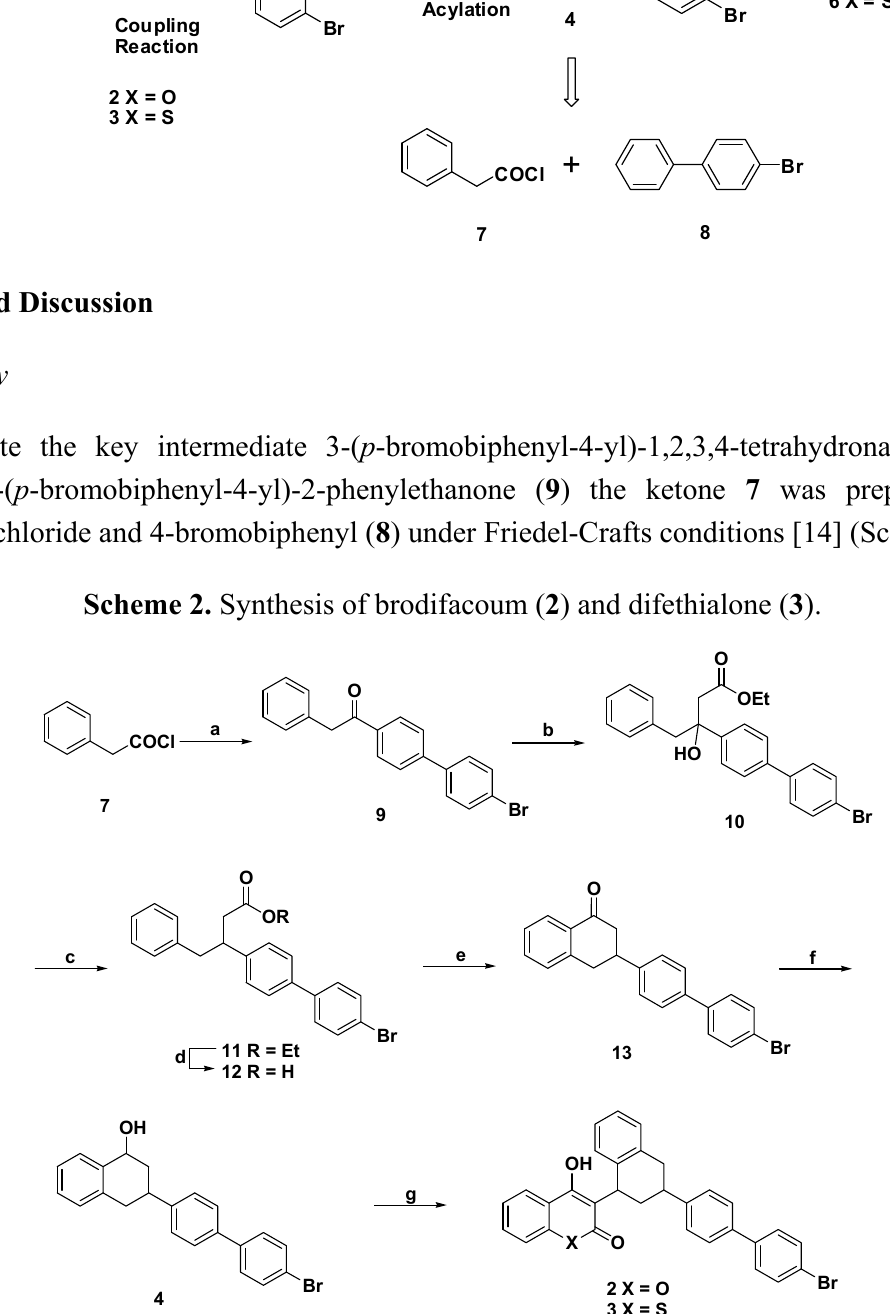
4Coupling Reaction